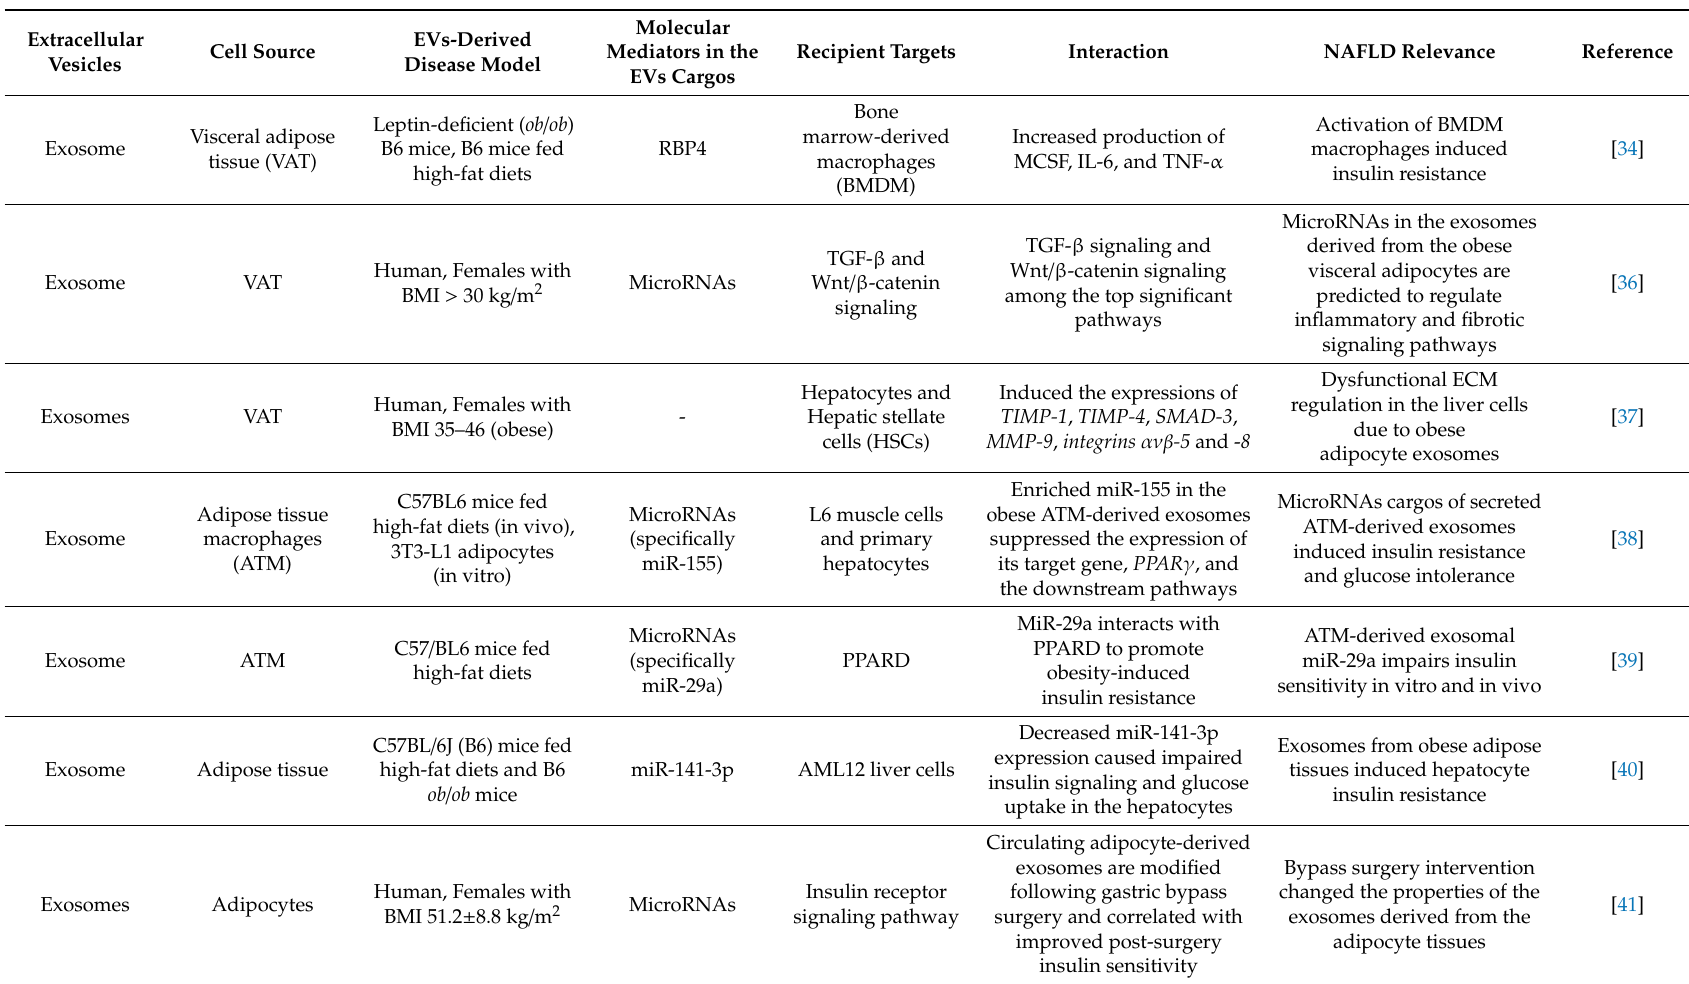
Table 1. Summary of the reported extracellular vesicles (EVs) from various sources and their clinical importance related to non-alcoholic fatty liver disease (NAFLD). Extracellular